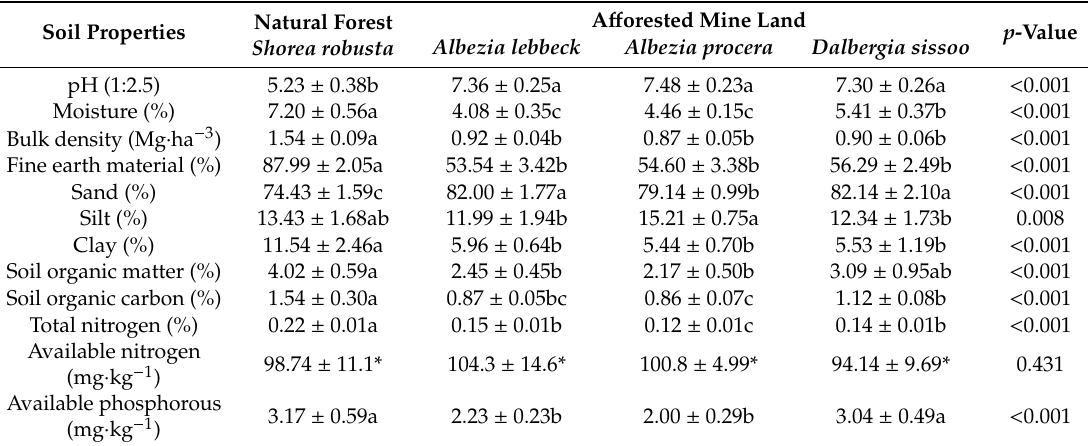
Table 2. Changes in soil physicochemical properties after a ff orestation of reclaimed mine land with di ff erent fast-growing trees and natural